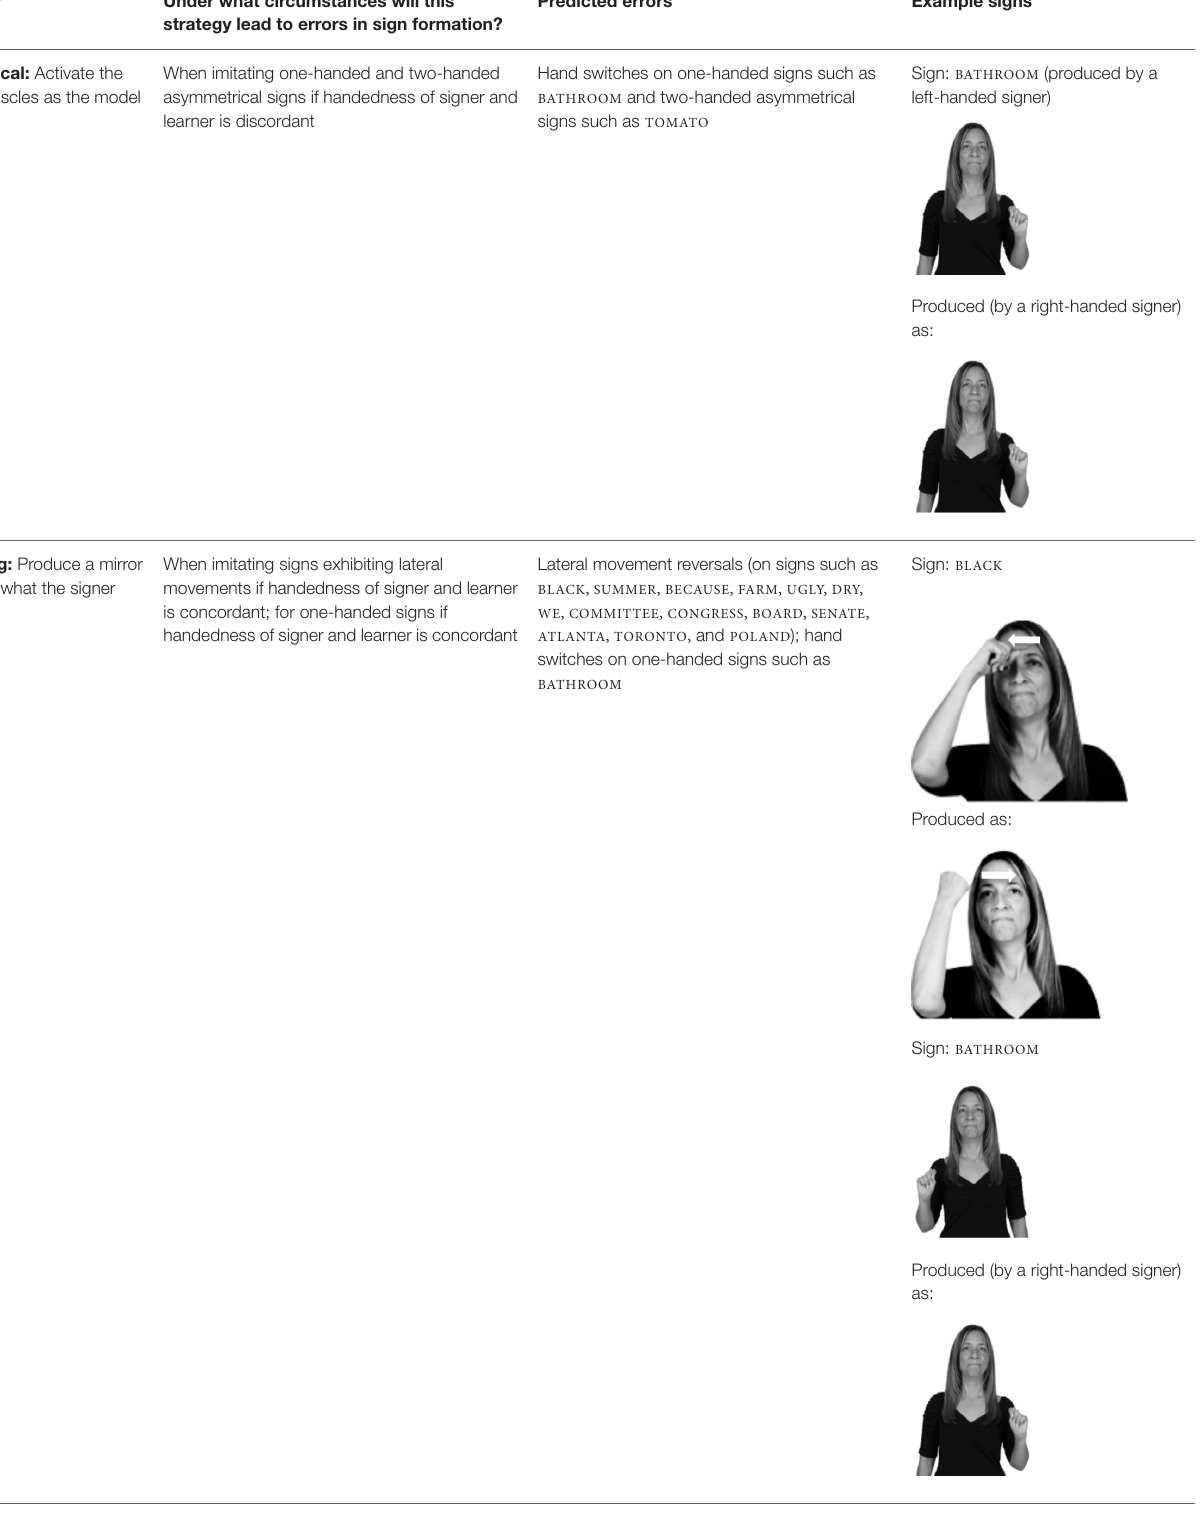
TABLE 1 | Four imitation strategies in sign learning and predicted error types.